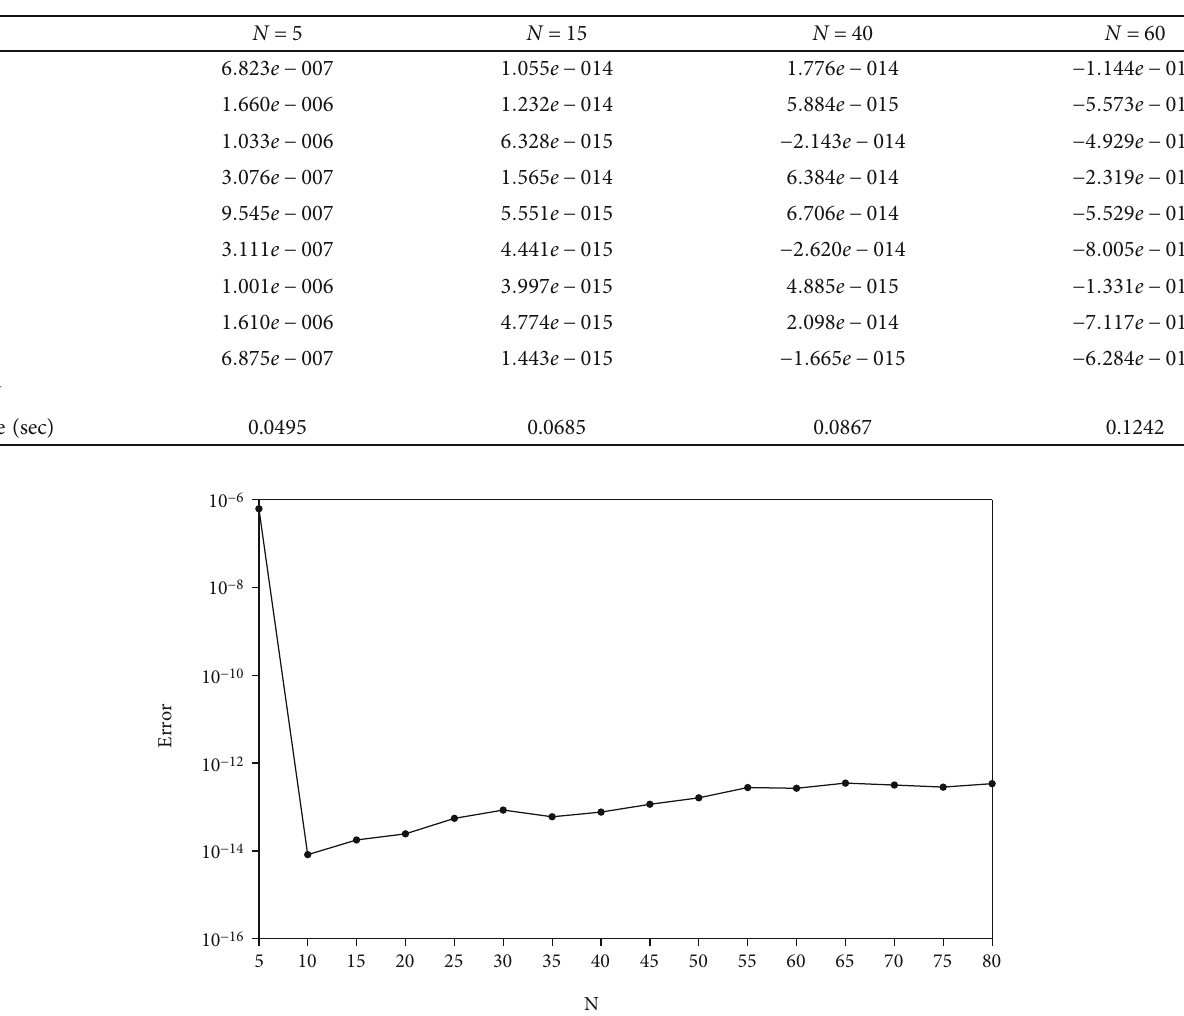
Table 1: Maximum absolute errors of Example 1 for di ff erent values of x and N .